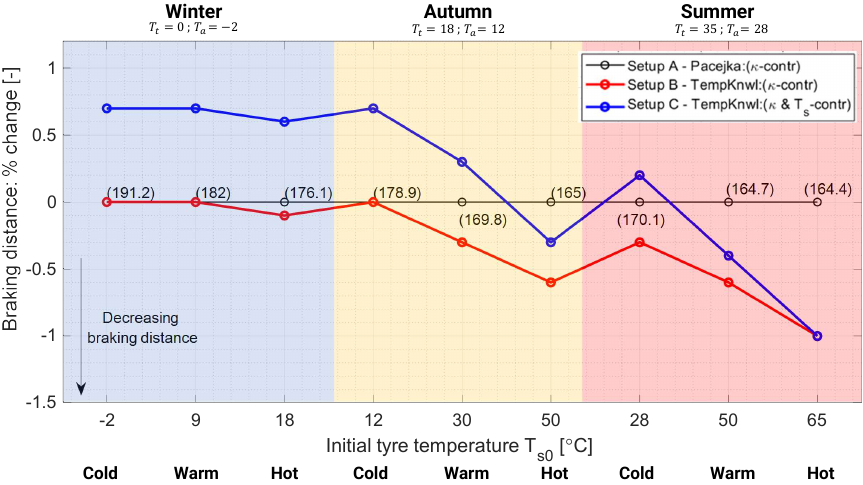
Figure 22. Percentage change in braking distance relative to Setup A starting at 40 m/s for tests 1–9, as shown in Figure 20. The absolute value of braking distance for Setup A is stated below each data point as ( s br ) .